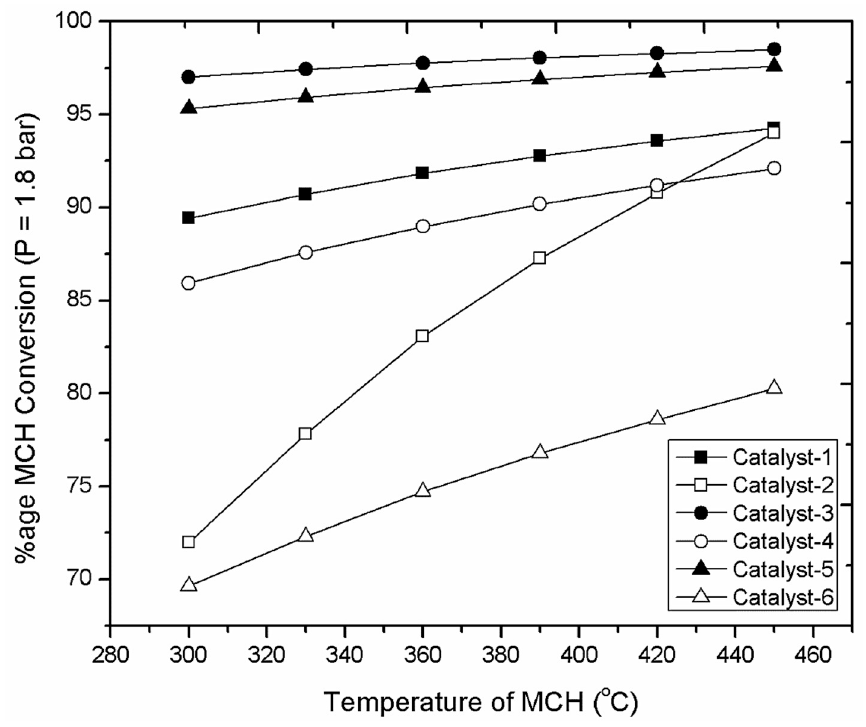
Figure 4. Effect of catalyst category on the percentage of MCH conversion at P = 1.8 bar, H 2 /MCH = 0.5.